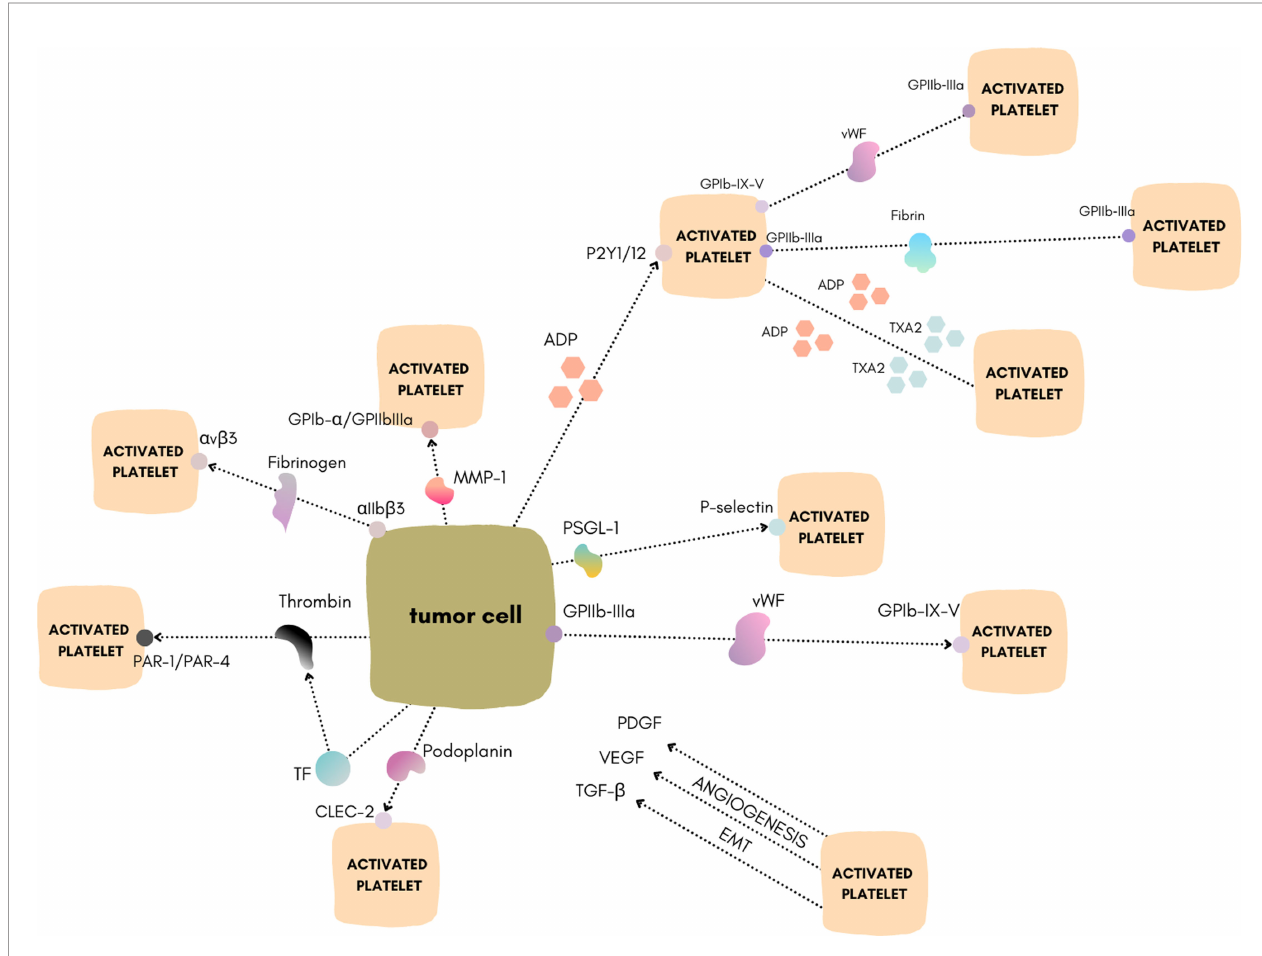
FIGURE 1 | Schematic of the different mechanisms of TCIPA. Figure created using